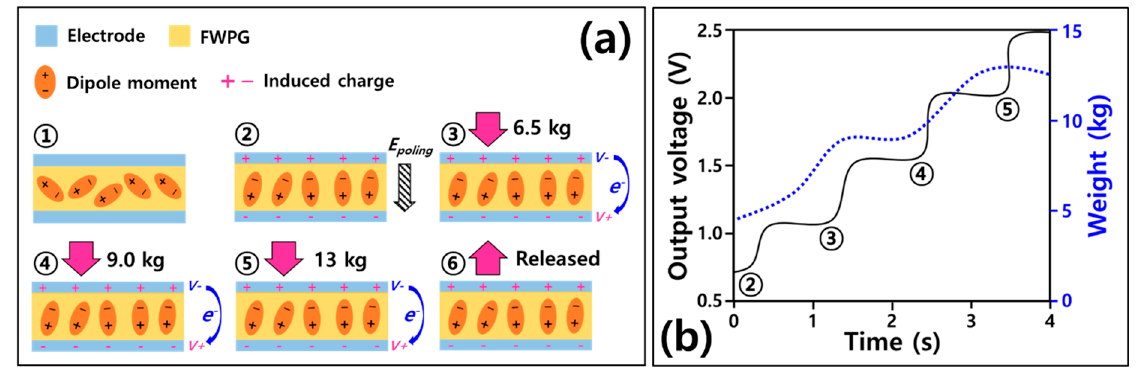
Figure 5. ( a ) Schematic diagram of energy conversion mechanism of the FWPG. ( b ) The electric output with the different vertical mechanical force values.